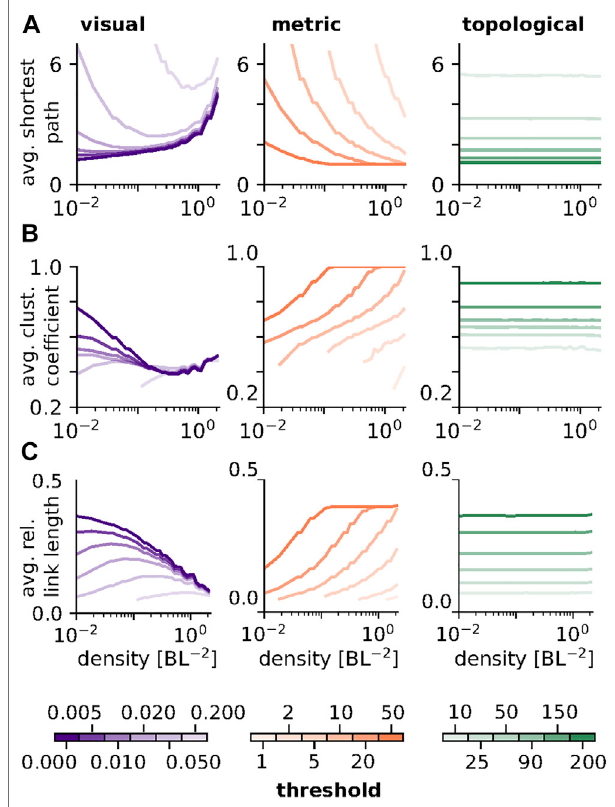
FIGURE 2 | Density dependence of network measures: (A) Average shortest path length as a function of density for all three network types. In visual networks the shortest path length assumes a threshold dependent minimum. In metric networks shortest path length decreases with density. In topological networks no density dependence is observed. (B) Average clustering coef fi cient as a function of density for all three network types. In visual networks the average clustering coef fi cient assumes a minimum at intermediate to high densities. The average clustering coef fi cient increases with density in metric networks and shows no density dependence in topological networks. (C) Average relative link length as a function of density. Visual networks exhibit a threshold dependent maximum while for metric networks link length increases with density. Again, topological networks show no dependence on density. N (cid:1) 225 was used for all